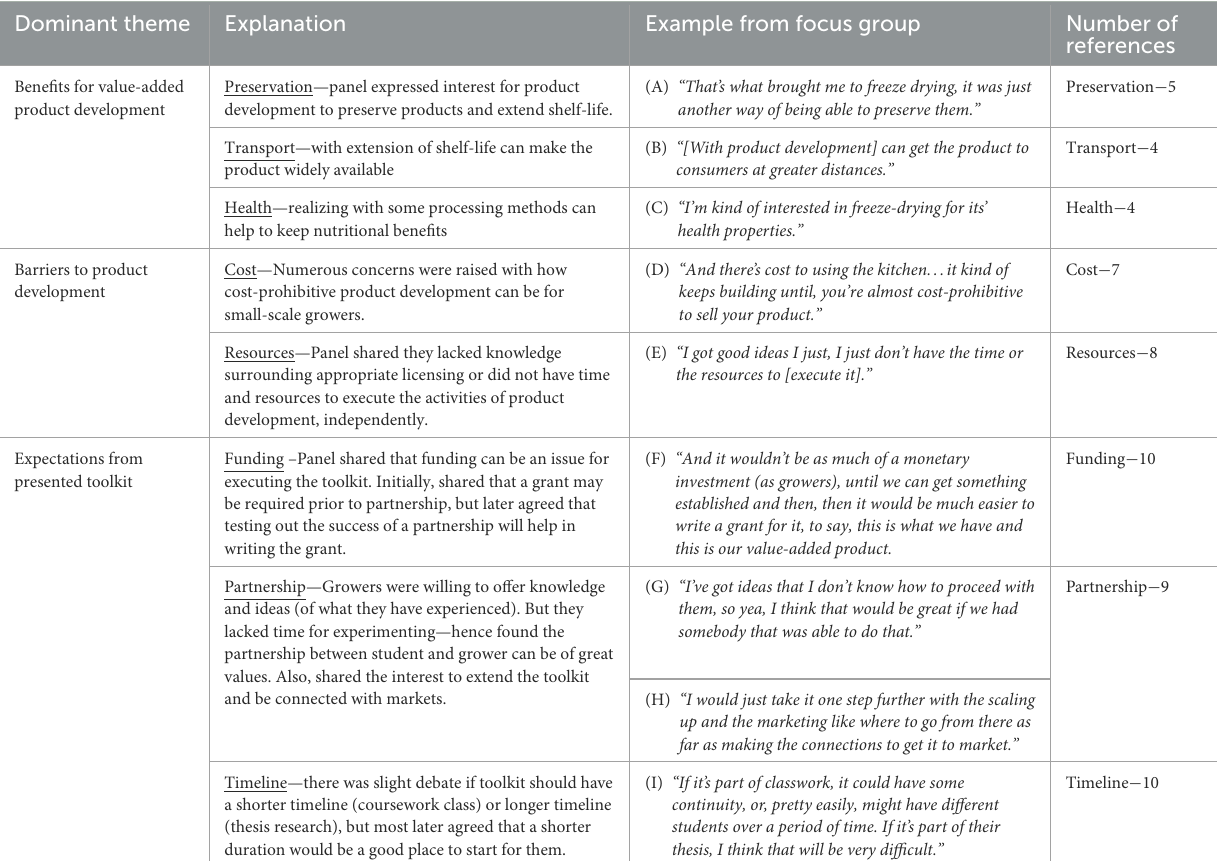
TABLE 2 Dominant themes from the focus group discussion with specialty fruit growers in